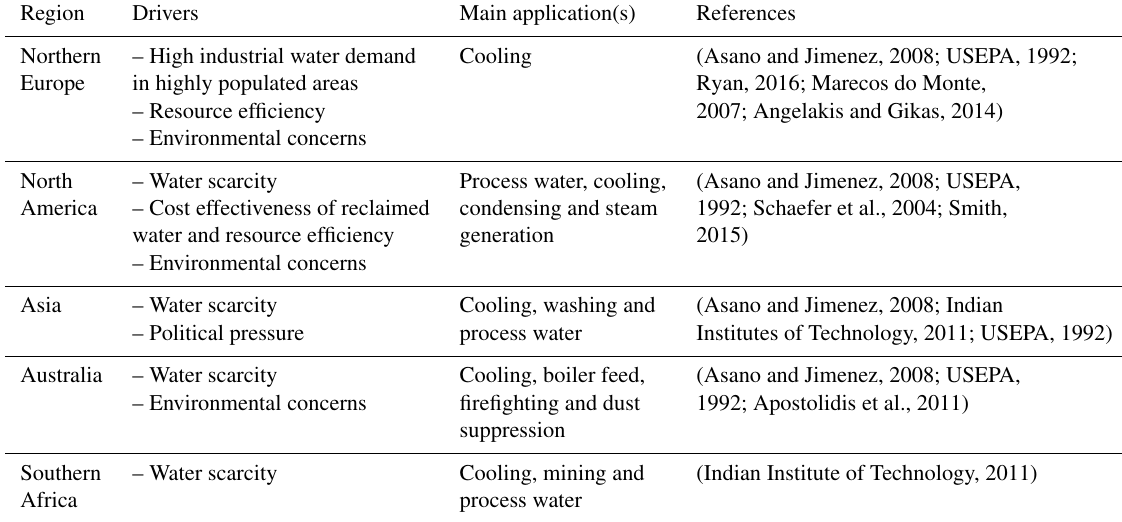
Table 1. Regional variation in water reclamation for industrial application. Region